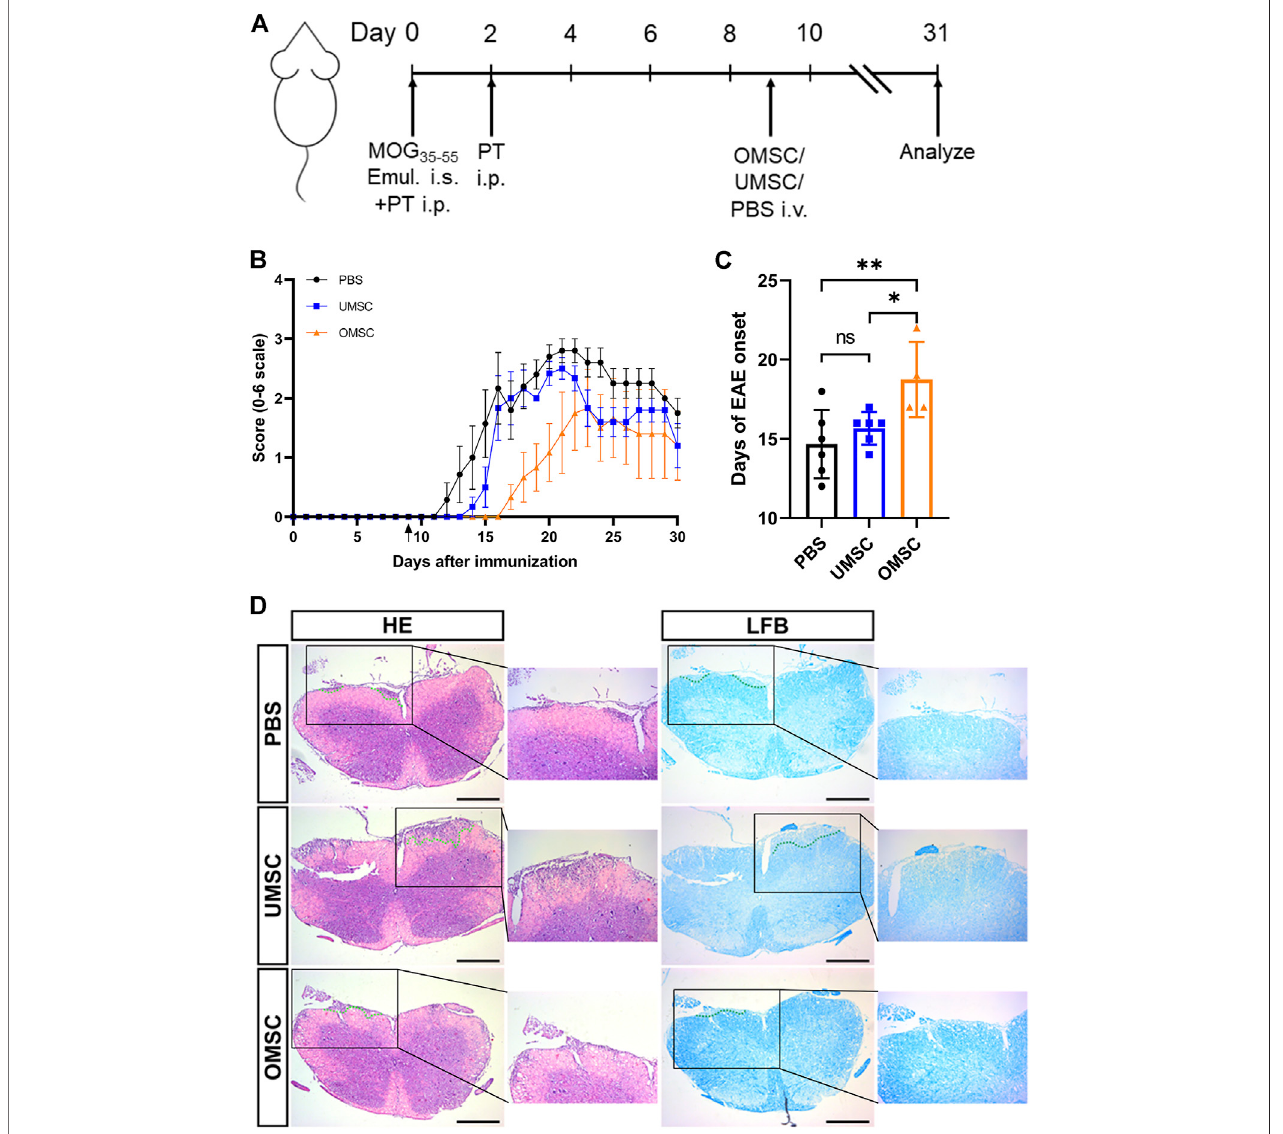
FIGURE 2 | Preventive effects of early intervention of OMSC and UMSC treatments on EAE mice: (A) Model diagram of the experimental process. (B) Effects of preventive treatment of OMSC and UMSC on the neurological function of EAE mice ( n (cid:1) 6 – 7). (C) Effects of preventive treatment of OMSC and UMSC on the onset of EAE in mice. (D) HE staining and LFB staining of the spinal cord of EAE mice. i.s.: subcutaneous injection; i.p.: intraperitoneal injection; i.v.: intravenous injection. Bar: 400 μ m * p < 0.05; ns: the difference was not statistically signi fi cant.